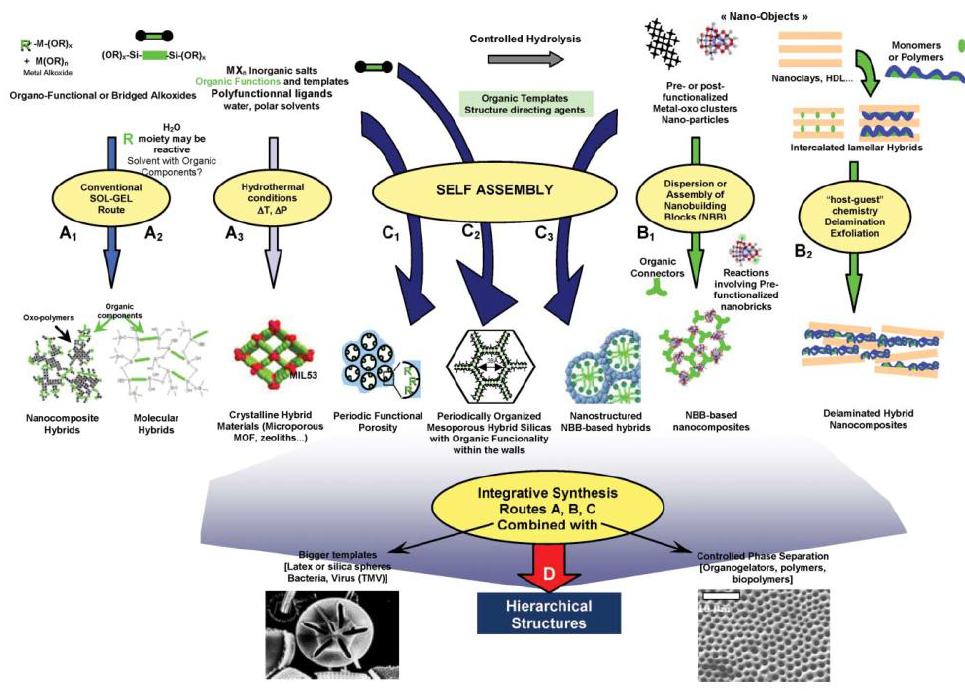
Figure 2. Scheme of the main chemical routes for the synthesis of organic-inorganic hybrids [11]. Reprinted with permission from [11]. Copyright 2005, Royal Society of Chemistry.